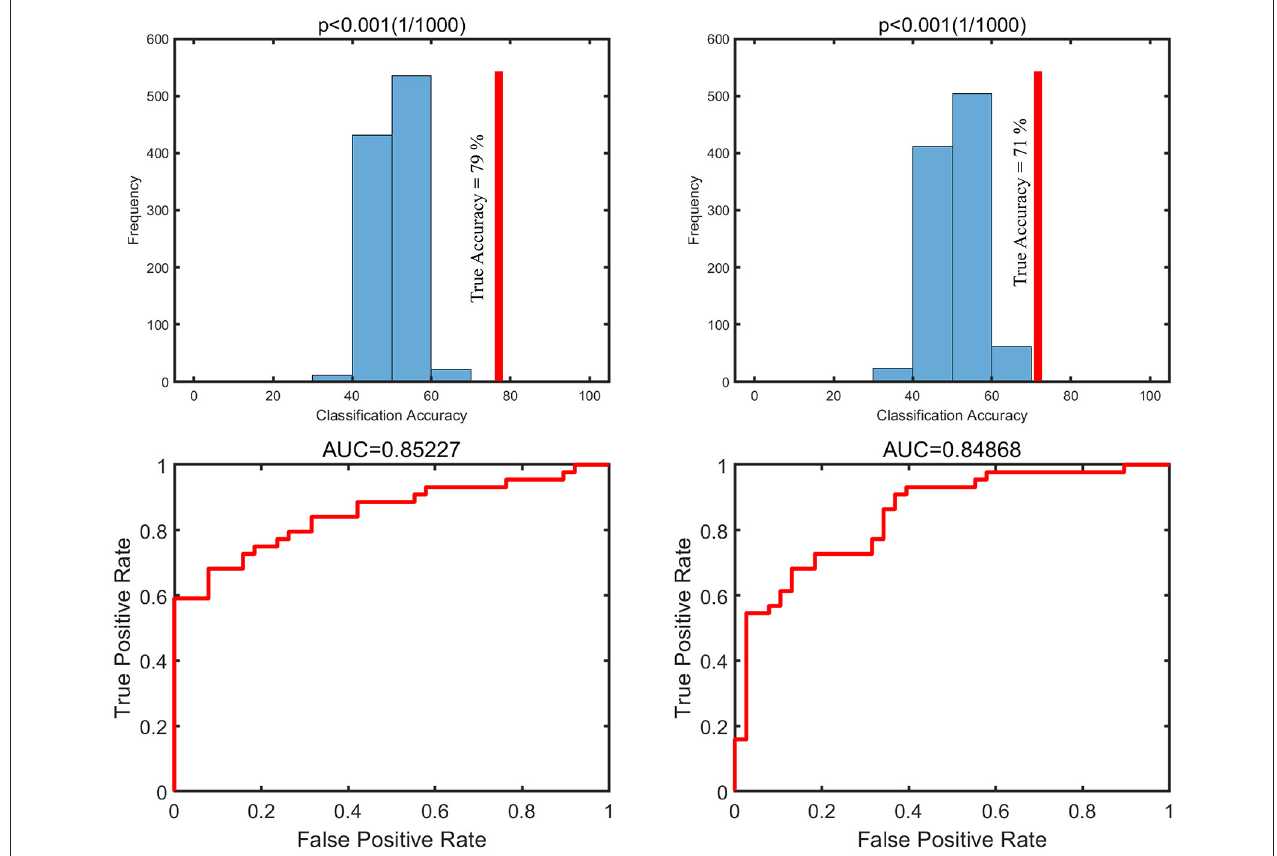
FIGURE 2 | The null distributions of the classifications and receiver operator characteristic curve (ROC curve) for DCM vs. HC using sALFF and dALFF. DCM, Degenerative Cervical Myelopathy; HC, Healthy Controls; sALFF, static amplitude of low-frequency fluctuation; dALFF, dynamic amplitude of low-frequency fluctuation; AUC, area under the